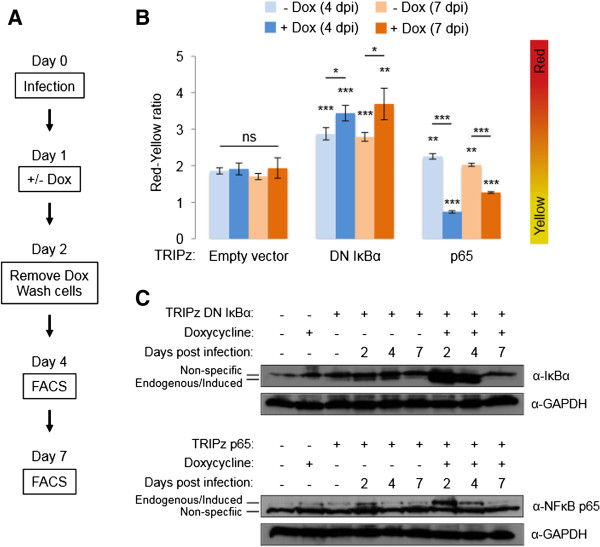
Direct alteration of NFκB activity near the time of infection is sufficient to modulate the frequency of non-productive RGH infection. A. Experimental outline for doxycycline-inducible NFκB modulation and RGH infection of Jurkat cells. B: Jurkat cells bearing a stably integrated, doxycycline-inducible expression construct containing either a dominant negative IκBα or p65 open reading frame were infected with RGH. Cells were cultured with or without doxycycline for 24 hours, and then washed and cultured in fresh media until analysis by flow cytometry at four and seven days post-infection. Error bars represent standard deviations of triplicate experiments. ‘ns’ non-significant, * p < 0.05, ** p < 0.01, *** p < 0.001 (Student’s T test). C: Immunoblot analysis of cells used in panel B. Jurkat whole cell extracts were separated by SDS-PAGE, transferred to nitrocellulose membrane, and blotted with antibodies against IκBα or p65.